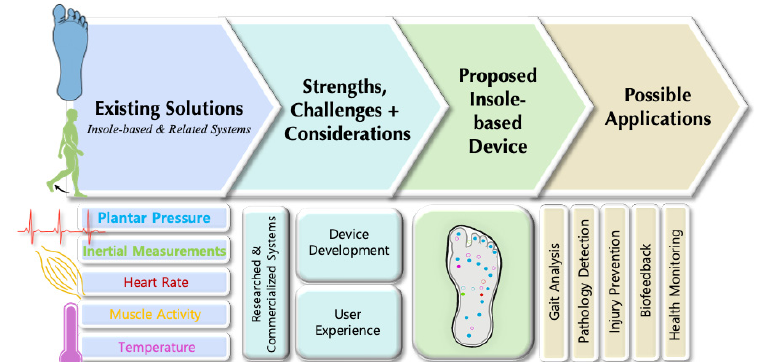
Figure 1. Overview of review article.